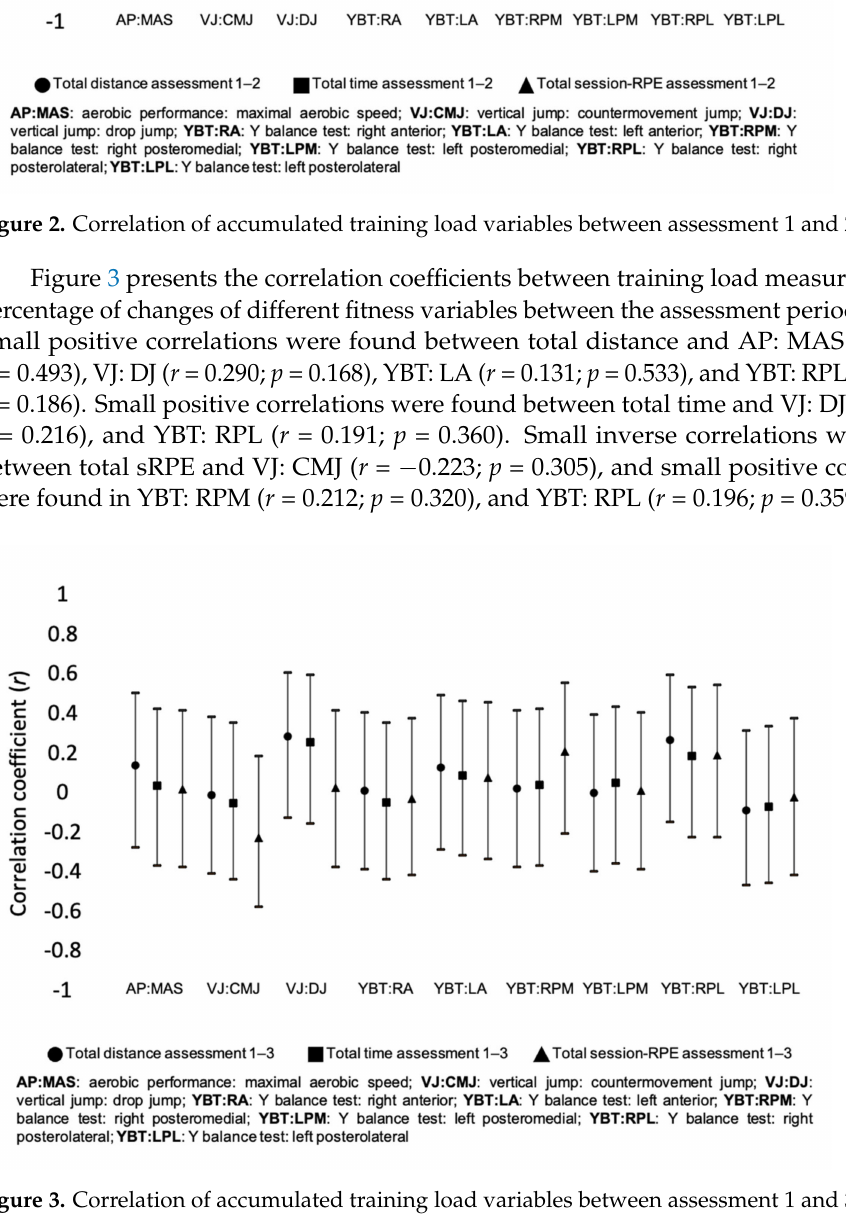
Figure 3. Correlation of accumulated training load variables between assessment 1 and